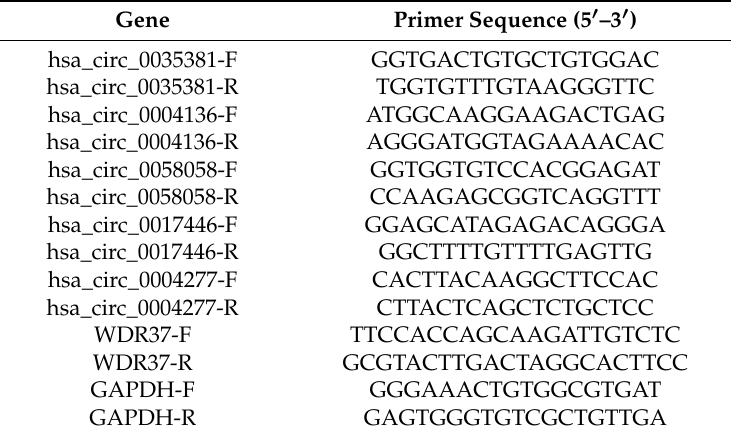
Table 4. Primers used for qRT-PCR in human samples.